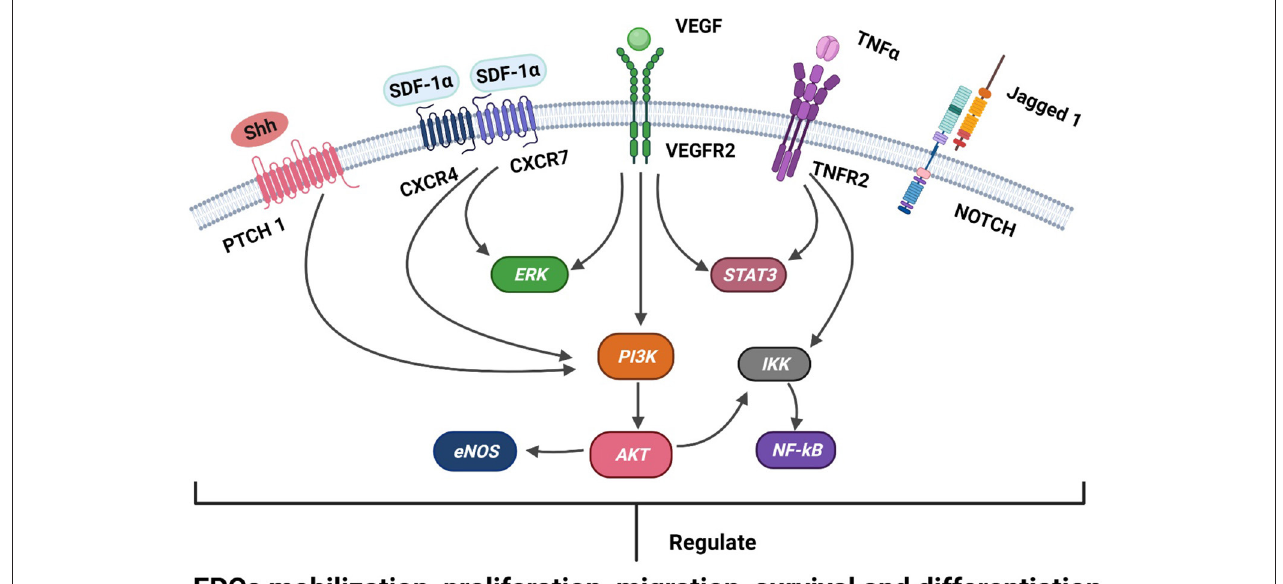
FIGURE 1 | A schematic representation of the known signaling mechanisms of EPC recruitment in ischemic heart disease is shown. Receptors (Patch, CXCR4, CXCR7, VEGFR2, TNFR2, and Notch) and ligands (SHH, SDF-1, VEGF, TNF α , and Jagged 1) are shown on the membranes of EPCs. The SDF-1 α /CXCR4/CXCR7, VEGFR, TNF α , SHH, and Notch signaling pathways engage in crosstalk with the intracellular PI3K/Akt/eNOS, ERK1/2, STAT3, and NF-kB pathways and regulate the development of EPCs in ischemic heart disease, including the mobilization, proliferation, migration, survival, and differentiation of